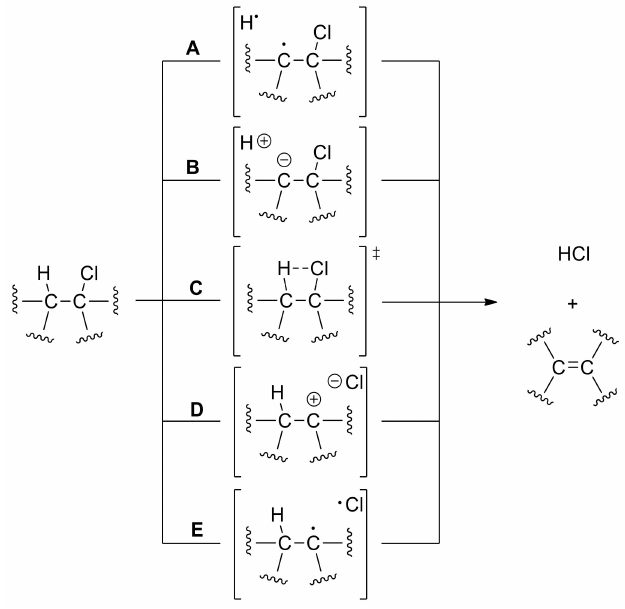
Scheme 2. Theoretically possible mechanisms of the HCl extrusion process from organic